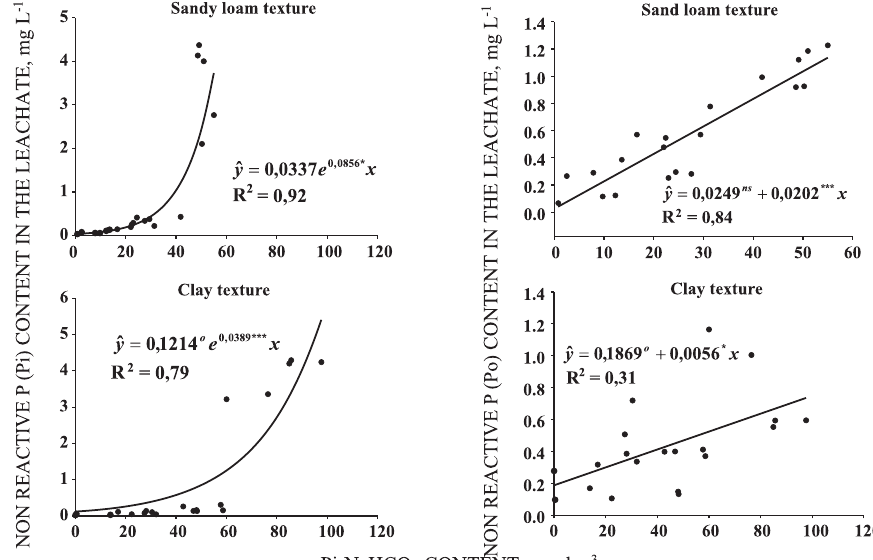
Figure 7. Variation in P reactive (Pi) and P non-reactive (Po) contents in the leachates according to the contents of Pi-NaHCO in the first ring (0–10 cm) in samples of two Latosols with sandy loam and clay 3 texture, with increasing mineral P rates corresponding to the percentages of Maximum Phosphorus Adsorption Capacity (MPAC), under the influence of increasing poultry litter rates. ns , o , *, ***: not significant and significant at 10, 5, and 0.1 %,